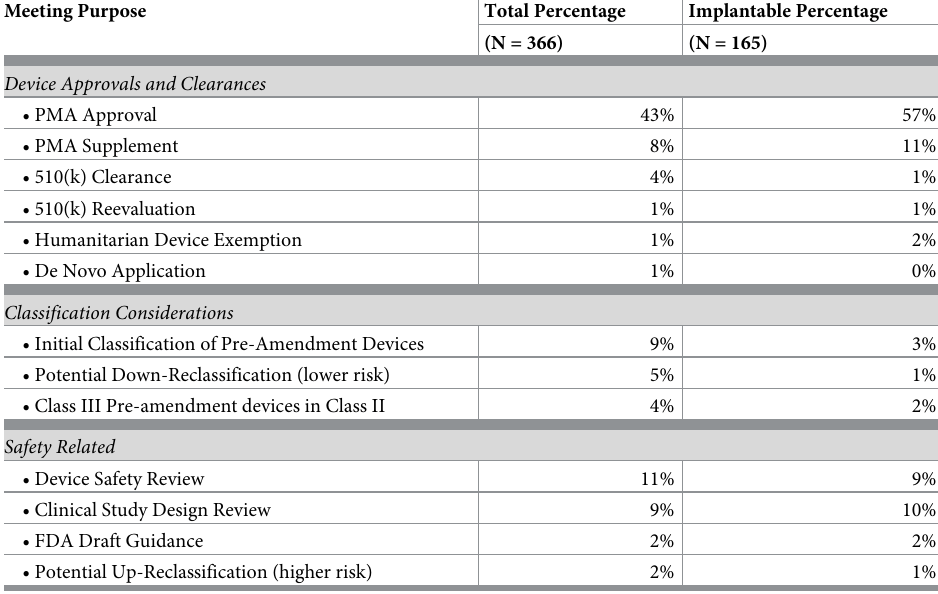
Table 1. FDA medical device meetings purpose,